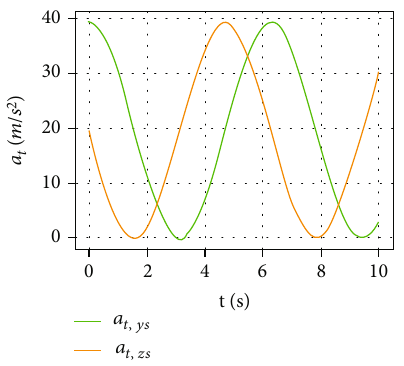
Figure 11: Acceleration of sinusoidal maneuvering